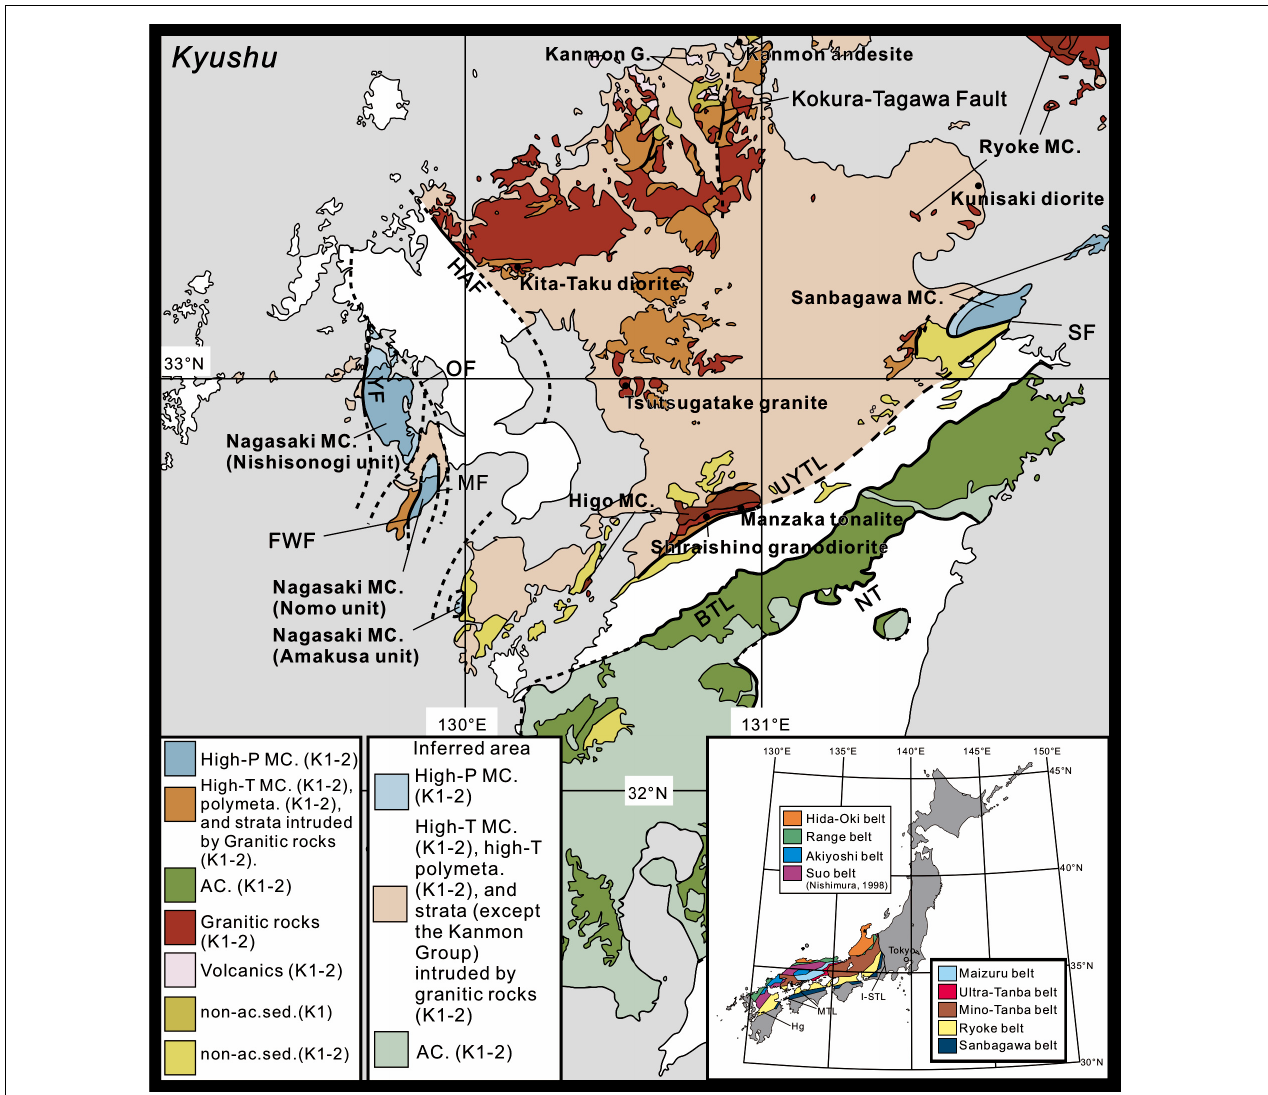
FIGURE 1 | Distribution of Cretaceous accretionary complex, metamorphic complex, plutonic rocks, volcanic rocks, and non-accretionary sedimentary rocks in Kyushu, SW Japan [modified from Miyazaki et al. (2016) based on the seamless geological map of Japan (1:200,000), Geological Survey of Japan, https://gbank.gsj.jp/seamless/index_en.html] with solid circle indicating the locality of granitic rock samples of which the thermodynamic modeling was modeled in this study. UYTL, Usuki–Yatsushiro Tectonic Line; BTL, Butsuzo Tectonic Line; SF, Sashu Fault; HAF, Hatashima–Ariake Fault; FWF, Fukabori–Wakimisaki Fault; OF, Omurawan–Amakusa Fault; YF, Yobikonoseto Fault; MF, Mogi Fault; NT, Nobeoka Thrust; MC, Metamorphic Complex; AC, Accretionary Complex; polymeta, polymetamorphic rocks; non-ac.sed., non-accretionary sedimentary rocks; K1–2, Early–Late Cretaceous; K1, Early Cretaceous. Inset-map showing a geotectonic map of SW Japan (modified form Nishimura, 1998 with permission). MTL, Median Tectonic Line; I–STL, Itoigawa–Shizuoka Tectonic Line; Hg, Higo